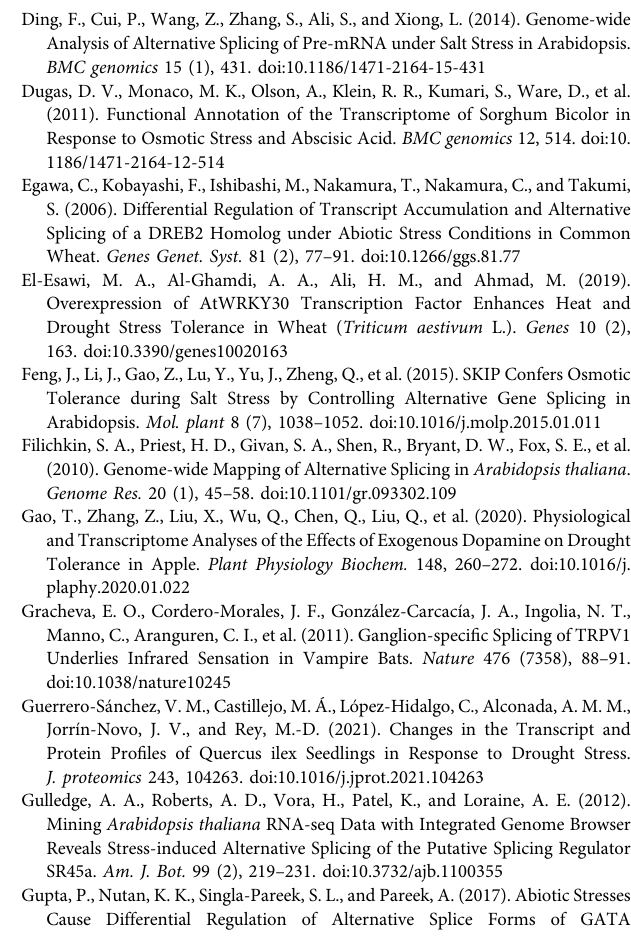
RS2Z33). (phosphatidylinositol-glycan biosynthesis class F protein). Bar graphs present the relativeexpression levelsofselectivelysplicedisoforms1(blue)and2(orange)under various drought stress conditions as determined by the RNA-seq analysis. The number in each blue/orange bar represents the proportion of the expression corresponding to isoforms 1/2. Supplementary Figure S6 | AS pro fi les of stress-responsive genes under APDS and UPDS conditions. (A) Glyur001192s00036935 (18.1 kDa class I heat shock protein). (B) Glyur000490s00023923 (22 kDa heat shock protein). (C) Glyur002052s00038821 (probable WRKY transcription factor 19). (D) Glyur000092s00007537 (probable WRKY transcription factor 20). (E) Glyur001392s00030472 (probable protein phosphatase 2C 76). (F) Glyur000061s00006499 (probable protein phosphatase 2C 6). (G) Glyur000105s00014180 (protein phosphatase 2C 16). (H) Glyur000521s00021495 (probable protein phosphatase 2C 26). Bar graphs present the relative expression levels of selectively spliced isoforms 1 (blue) and 2 (red) under various drought stress conditions as determined by the RNA-seq analysis. The number in each blue/red bar represents the proportion of the expression corresponding to isoforms 1/2. Supplementary Figure S7 | Relative expression of HSP22 (A) , WRKY19 (B) , WRKY20 (C) , and PP2C (D) in licorice under APDS and UPDS conditions. Data are presented as the mean ± standard deviation of three biological replicates. The mean values for different time points under drought stress were analyzed using the Bonferroni test and T-test. Different letters indicate highly signi fi cant differences among treatments. *: p < 0.05, **: p < 0.01, a: p < 0.05, A: p <